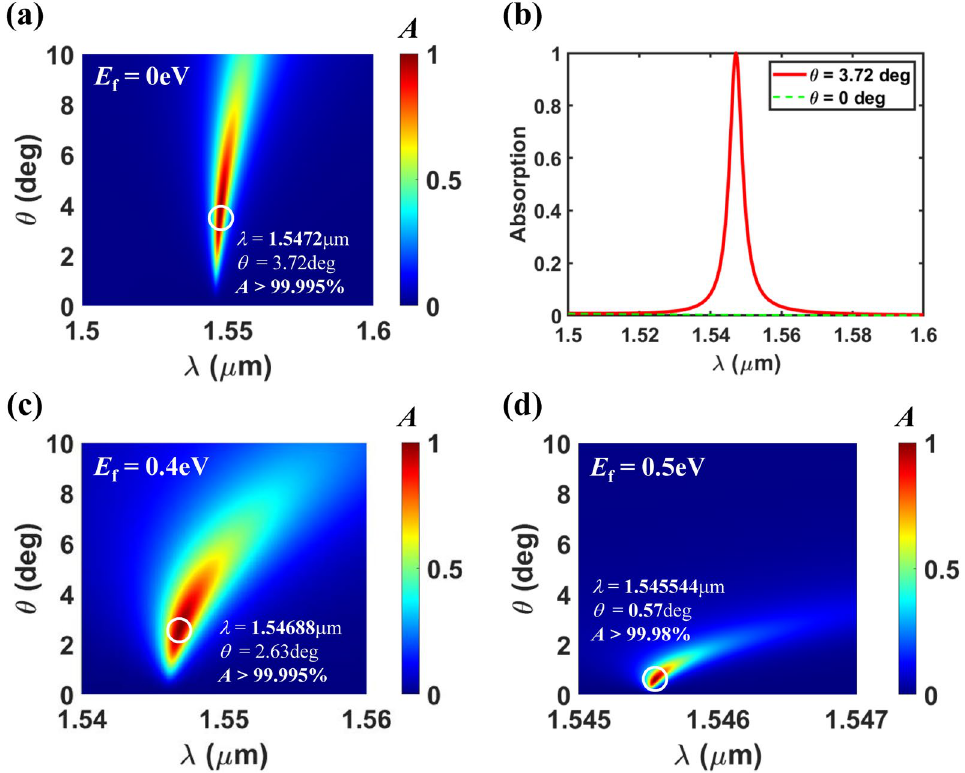
Figure 2. ( a ) Absorption spectra as a function of θ for the proposed graphene absorber, where E f = 0 eV, Period = 0.85 µ m, FF = 0.55, d Grat = 0.367 µ m, and d Slab = 0.052 m µ . ( b ) Absorption spectra extracted at two incidence angles ( θ = 0 and 3.72 deg), which are extracted from ( a ). Absorption spectra as a function of θ when ( c ) E f = 0.4 eV and ( d ) E f = 0.5 eV, assuming that all the remaining parameters are same as those of ( a